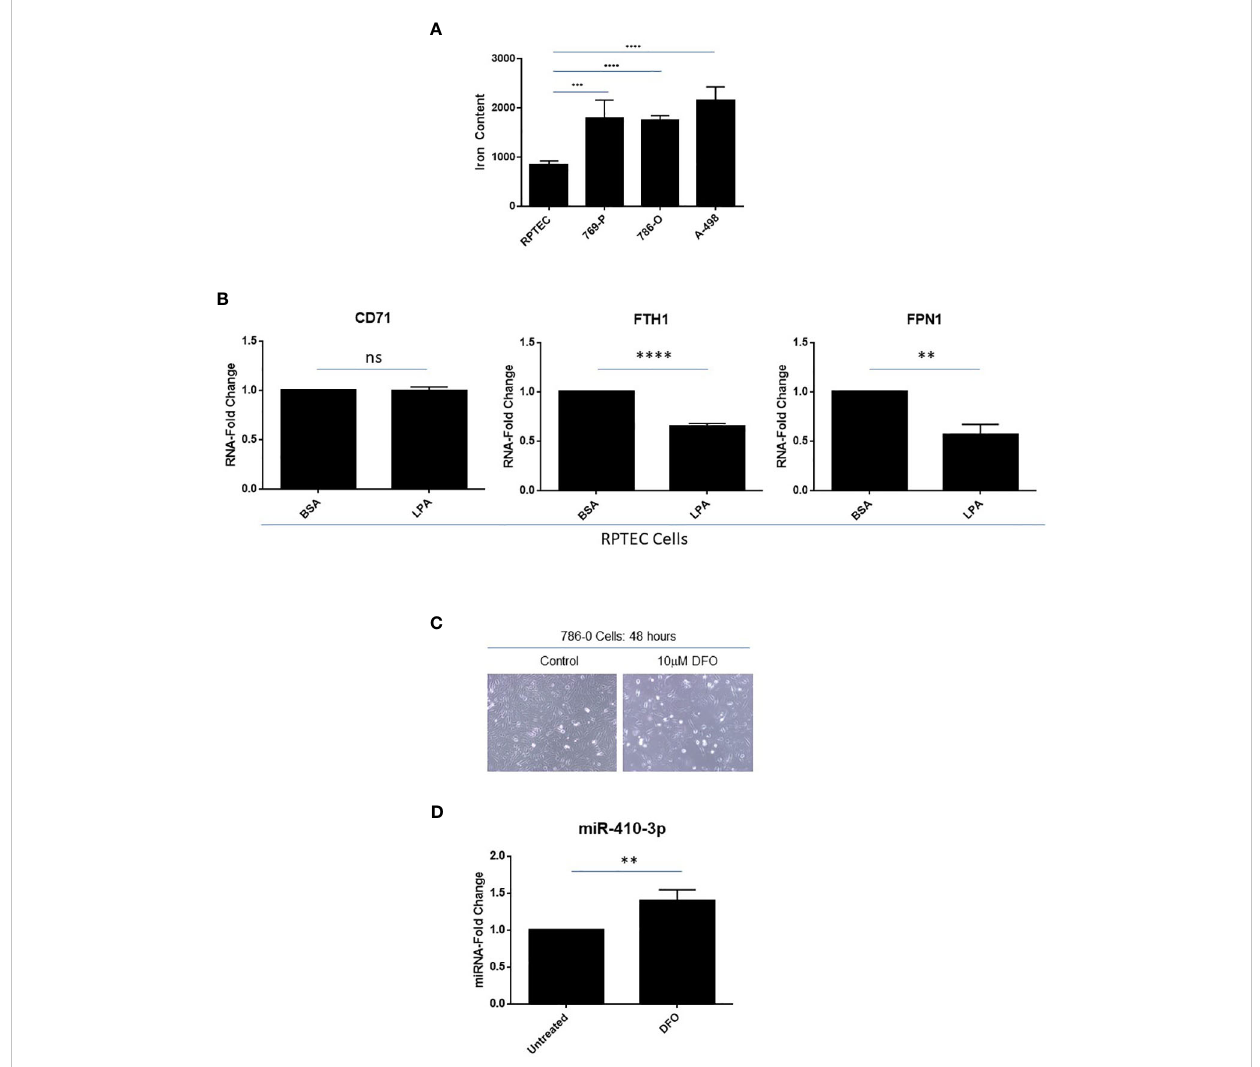
FIGURE 7 Elevated labile iron content in ccRCC with iron-dependent regulation of miR-410-3p, a 14q32 miRNA, in 786-O cells. (A) Labile iron was measured using FerroOrange in RPTEC, 769-P, 786-O, and A-498 cell lines. (B) qPCR analyses of CD71 , FTH1 , and FPN1 (normalized to PP1A ) in RPTEC in response to treatment with BSA (control) or LPA. The composite of three independent experiments is shown. (C) Light microscopic images of 786-O cells treated with 10 m M DFO for 48 hours were captured at 20x magni fi cation. (D) qPCR analyses of miR-410-3p (normalized to RNU48 ) in untreated and DFO-treated 786-O cells. ns, not signi fi cant; ** p -values ≤ 0.01; *** p -values ≤ 0.001; **** p -values ≤